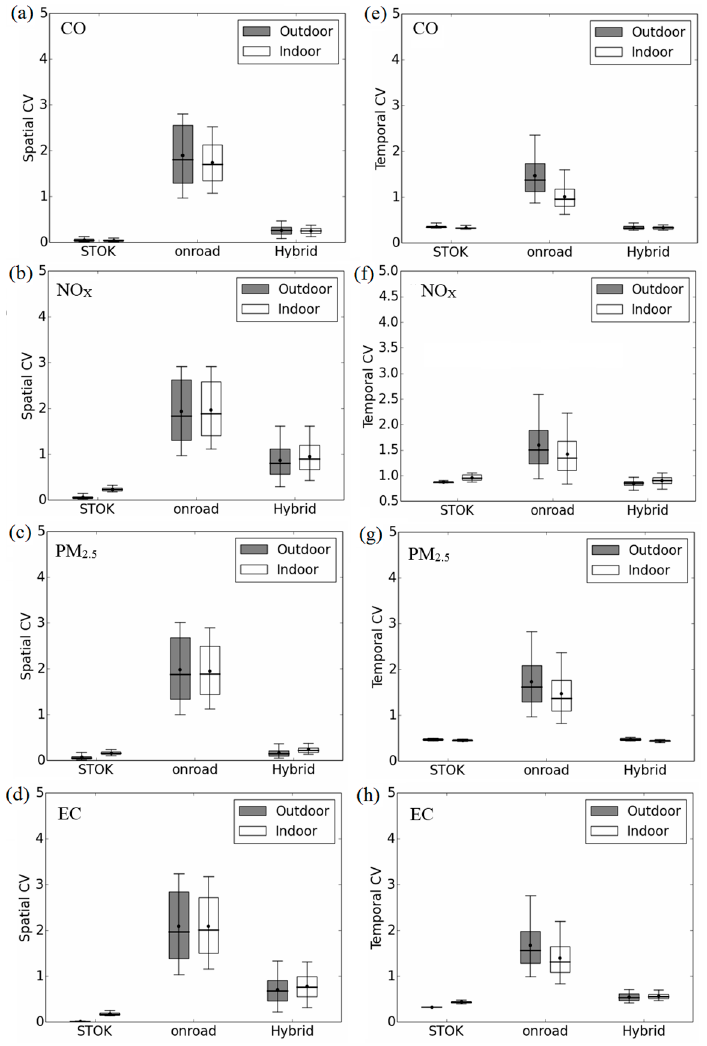
Figure 3. Spatial CV for each hour ( left panel ); and Temporal CV for each Census block ( right panel ) for CO ( a , e ); NOx ( b , f ); PM 2.5 ( c , g ); and EC ( d , h ). Bottom and top of box represents 25th and 75th percentiles, the line in the middle of the box is the median, the ends of the whisker are the 5th and 95th percentiles, and the dot on the whisker is the mean.